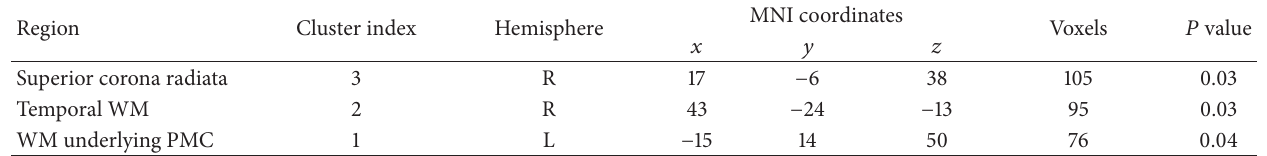
Figure 1: Results of TBSS analysis of FA maps (a, c, and e) and group probability maps (b, d, and f) from the corresponding regions. The mean white matter FA skeleton is shown in green. The blue mask indicates the PMC obtained from the J¨ulich histological atlas. The group probability maps were thresholded at 25% (at least 9 persons from the 35 subjects) and the color bar indicates the number of participants in whom the generating fiber pathways pass through that voxel. Table 2: Regions showing significant FA reduction in the